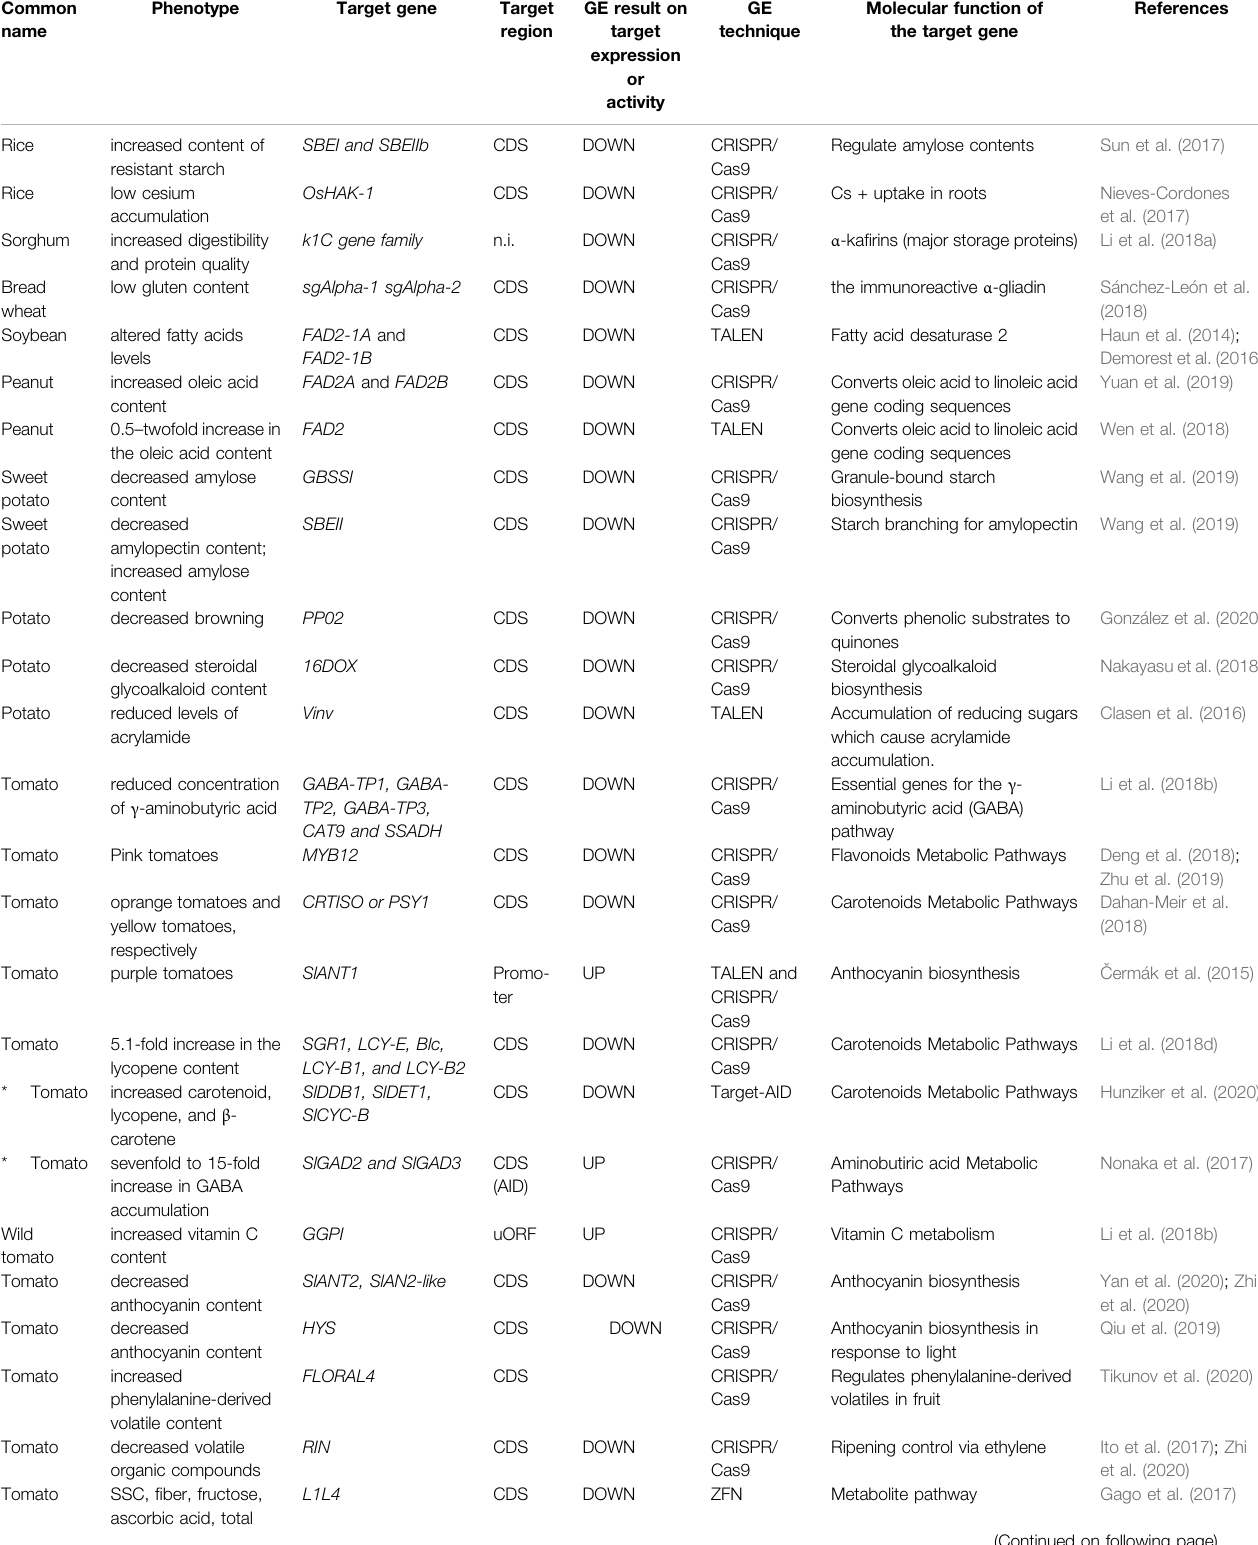
TABLE 1 | Applications of CRISPR/Cas9 in major crop species to improve nutritional